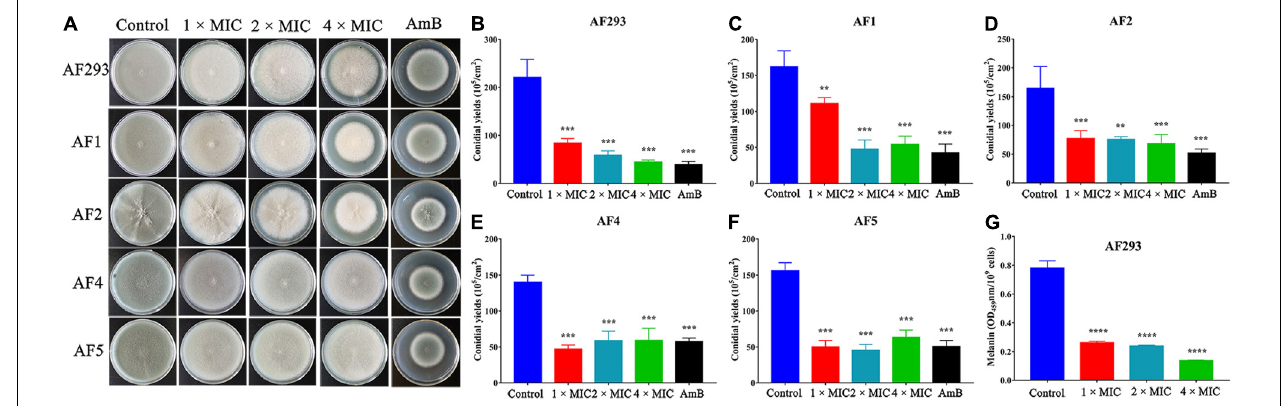
FIGURE 1 | Sodium new houttuyfonate (SNH) inhibits the asexual cycle of A. fumigatus . (A) Images of various concentrations of SNH treatment on PDA plates. The A. fumigatus strains AF293, AF1, AF2, AF4, and AF5 were incubated at a concentration of 10 5 cells/mL. Each dilution of 3 µ L was deposited on PDA solid medium with 1 × , 2 × , or 4 × MIC SNH; AmB (8 µ g/mL, positive control); or no drugs (negative control), then incubated at 37 ◦ C for 4 days. (B–F) Statistical analysis of A. fumigatus conidia yields under SNH treatment. (G) Measurement of A. fumigatus conidial melanin. Melanin was isolated from AF293 conidia cultured on PDA solid medium with 1 × , 2 × , or 4 × MIC SNH. Melanin was purified with 2% NaOH, and the absorbance at 459 nm was measured spectrophotometrically. Results represent the average of three independent experiments ± SD, and the level of statistical significance was set at * P < 0.05. ** P < 0.01, *** P < 0.001, and **** P <